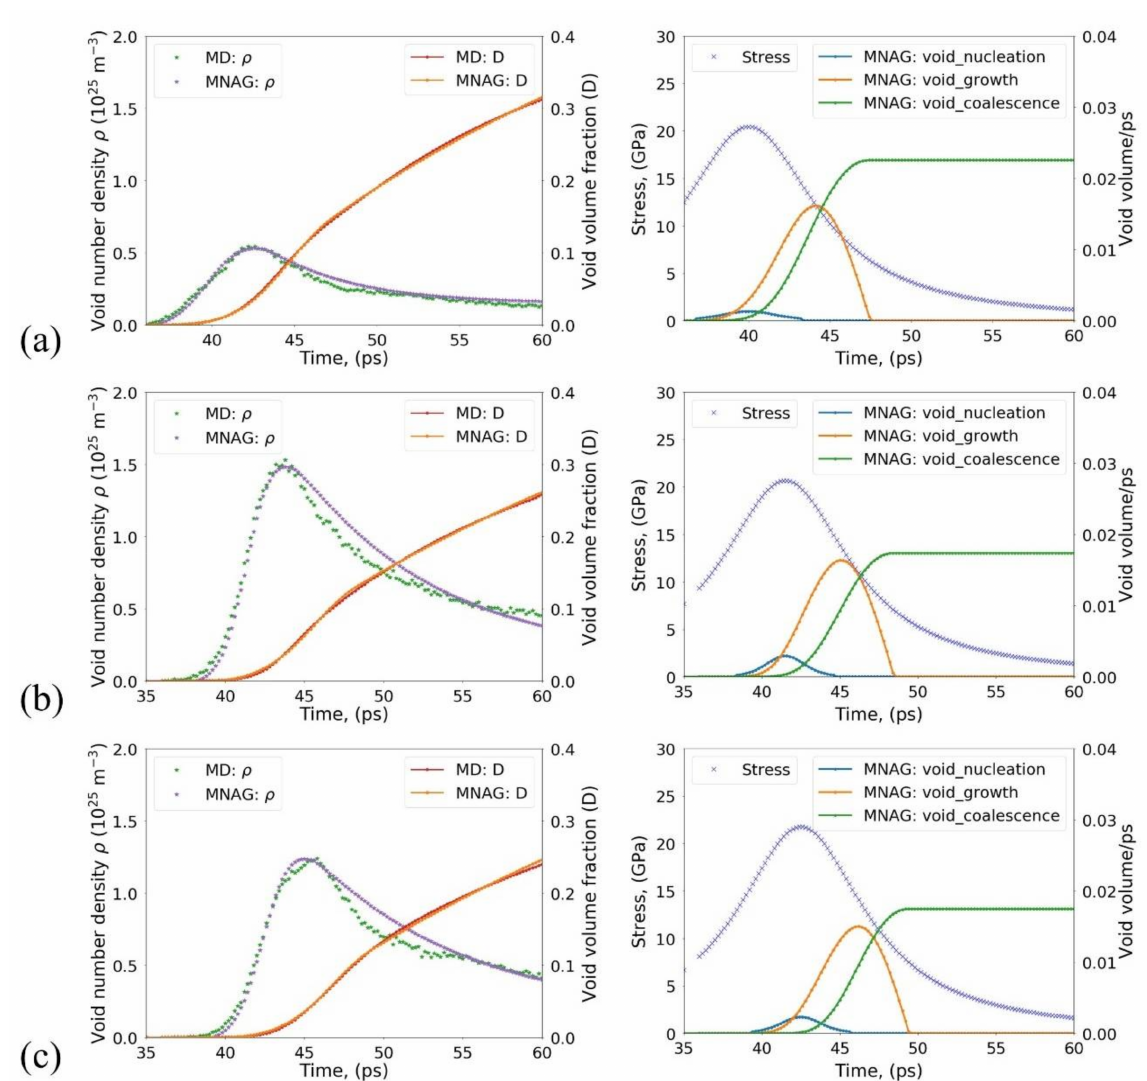
Figure 3. MNAG model fitted to single-crystal Ta along: ( a ) (001), ( b ) (110]), and ( c ) (111) orientation. The left-hand panels show the evolution of the void number density and damage based on MD and the MNAG model parameters, and the right-hand panels show the evolution of stress ( σ m ) and the contribution from void nucleation, growth, and coalescence terms over time based on the MNAG